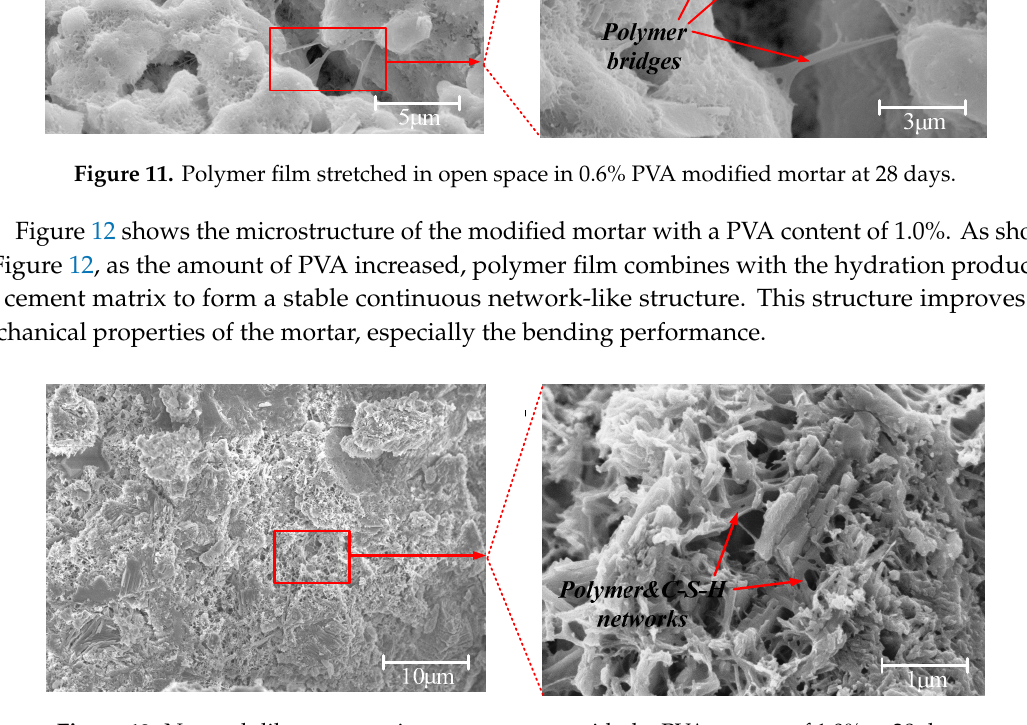
Figure 12. Network-like structure in cement mortar with the PVA content of 1.0% at 28 days.